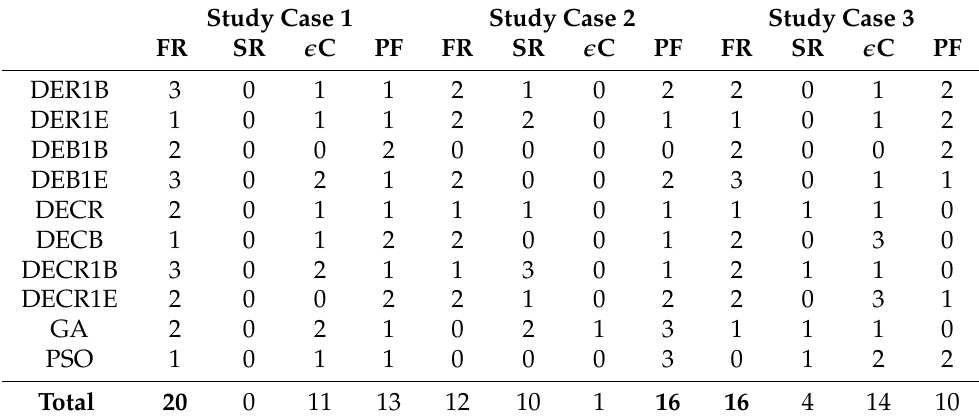
Table 8. The number of wins obtained by each algorithm through Friedman test for multiple comparisons using the execution best values as the